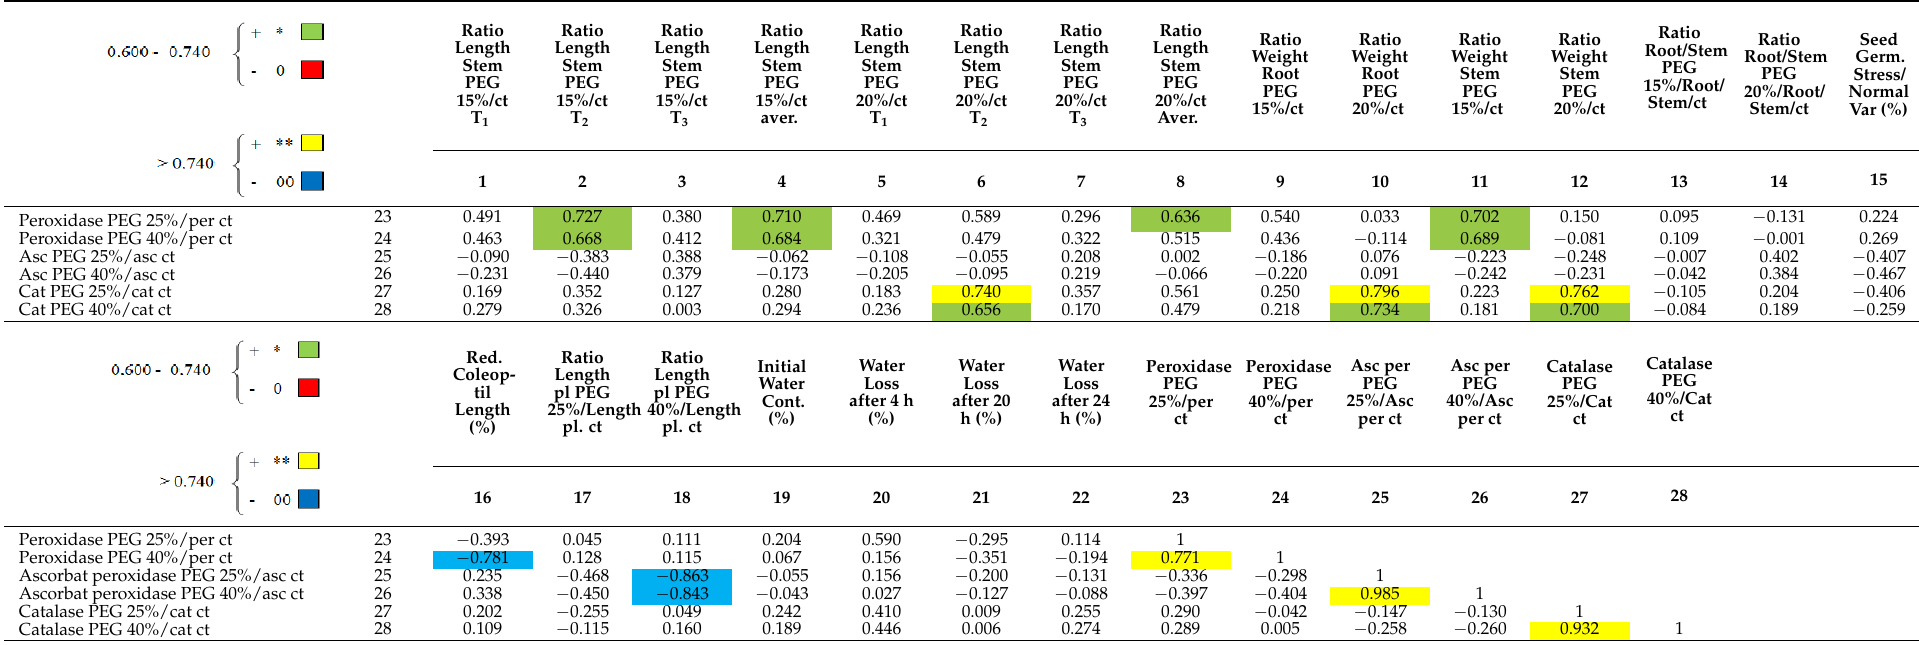
Table 5. Correlations between the characters determined in south-western Oltenia on a limited assortment of wheat varieties.